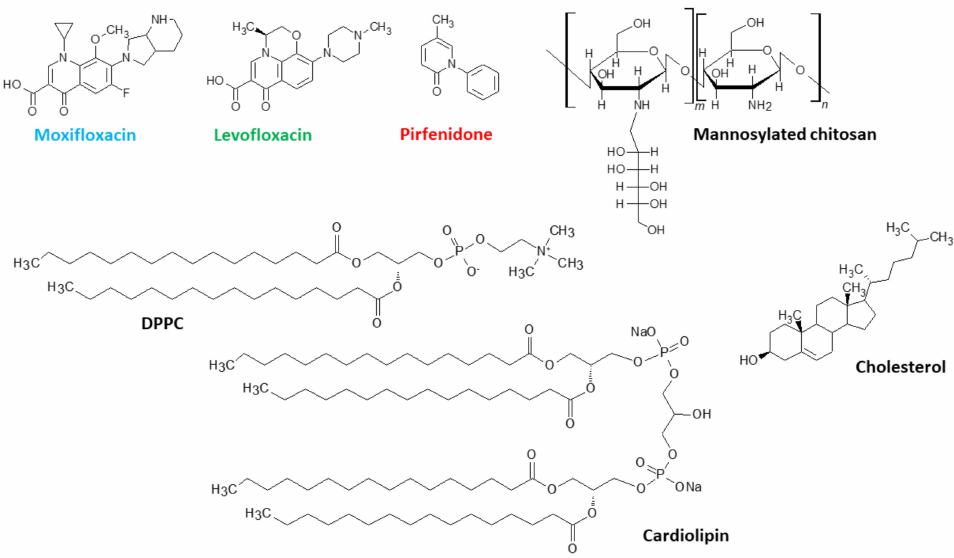
Figure 1. Formulae of the substances under consideration.